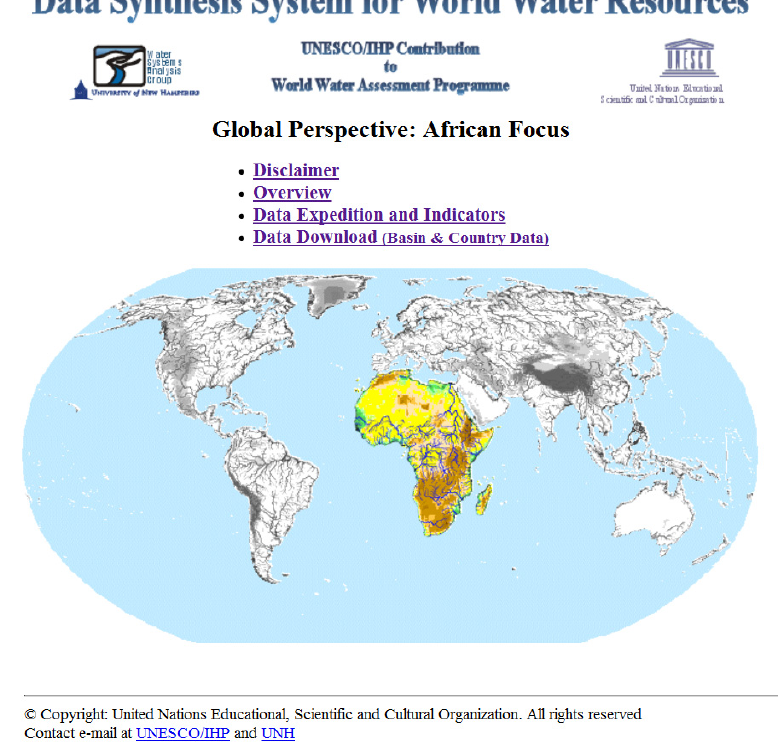
Figure 2. The Data Synthesis System (DSS) for World Water Resources